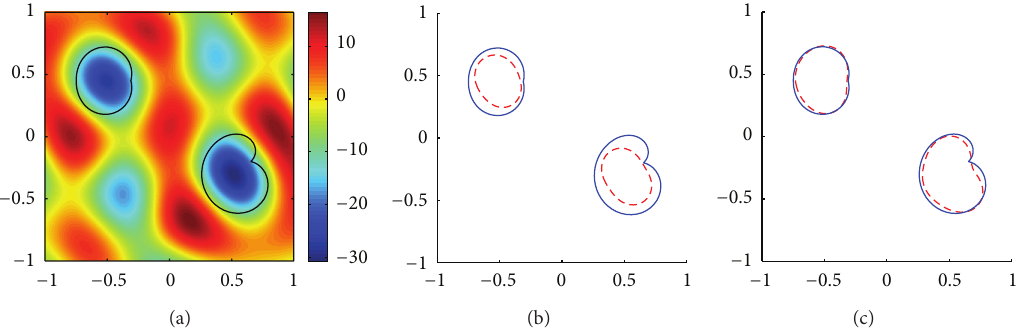
Figure 9: Reconstruction of rigid objects. (a) Topological derivative when Ω = 0 . (b) First guess of the objects (dashed red line). (c) Final reconstruction of the objects after 9 steps (dashed red